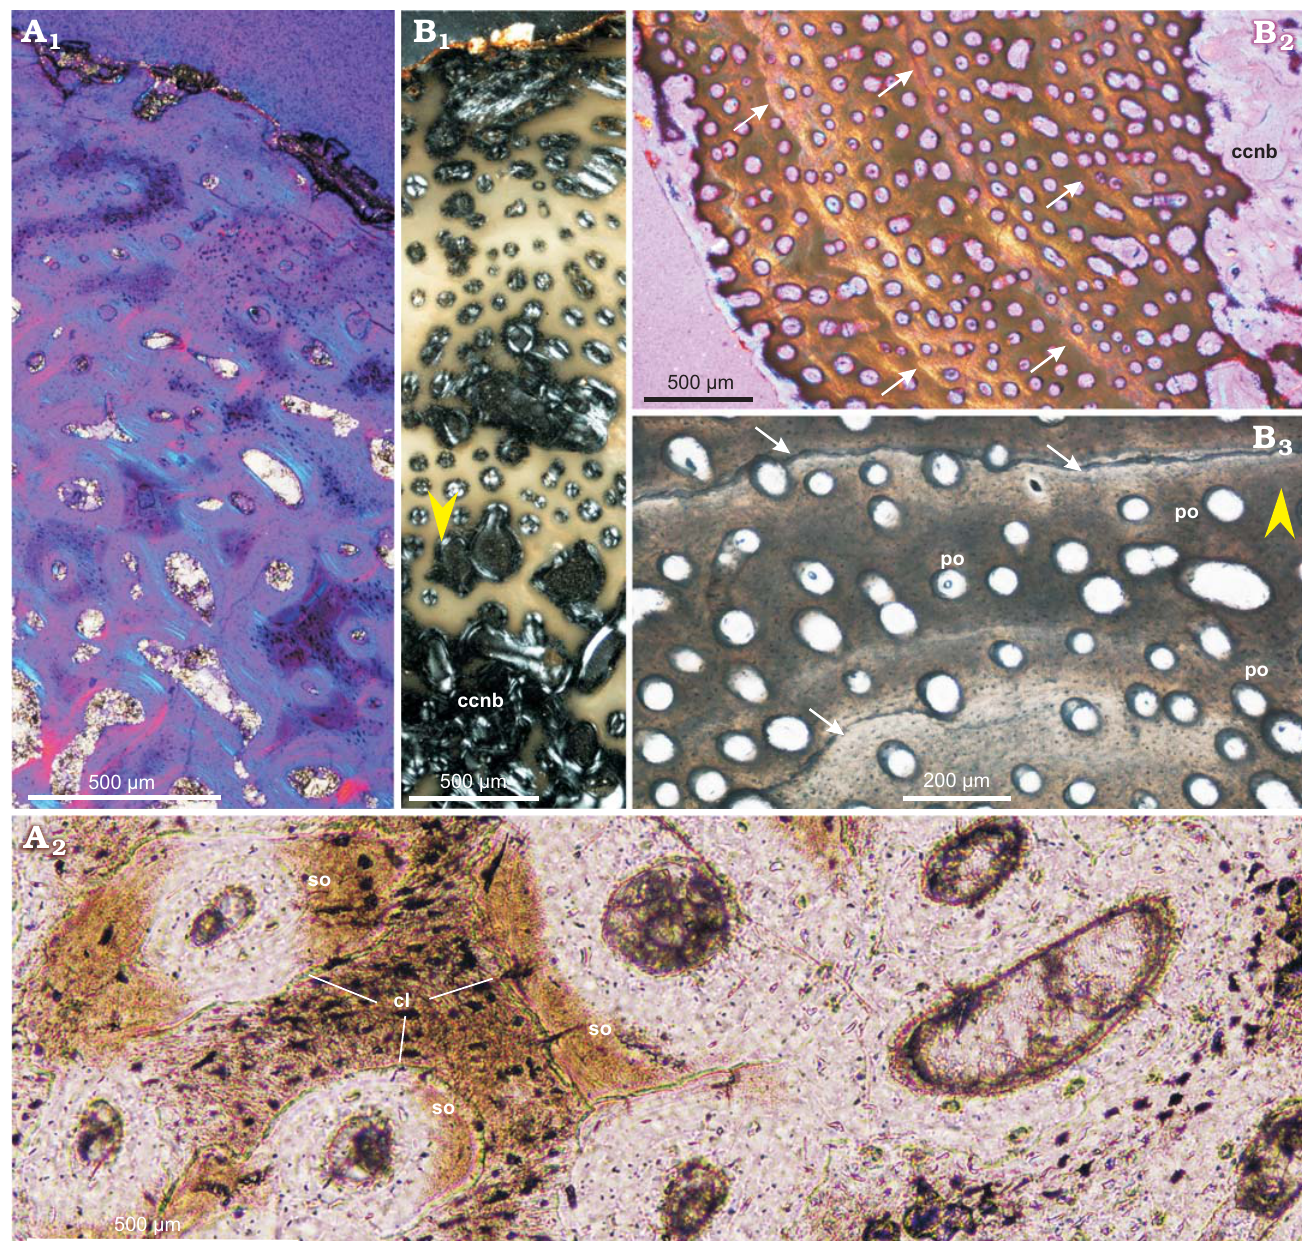
Fig. 7. Bone microstructure of juvenile femur ( A ) and tibia ( B ) of Protoceratops andrewsi Granger and Gregory, 1923, Bayn Dzak, Mongolia, Late Cretaceous. A . ZPAL MgD-II/407; outer cortex (A 1 ), showing small patches of parallel-fibered bone (light blue) and multiple primary osteons; canals are arranged longitudinally and the more internal cortex bears forming erosion lacunae; inner cortex (A 2 ). B . ZPAL MgD-II/408, section of the whole compacta showing coarse cancellous bone lined with endosteal lamellar bone in perimedullar region (B 1 ); tibial cortex displaying poli shing lines indicated by arrows (B 2 , B 3 ). Yellow arrowheads show outer bone perimeter. A 1 , B, polarized light; A 2 , normal light. Abbreviations: ccnb, coarse cancellous bone; cl, cement lines; po, primary osteons; so, secondary